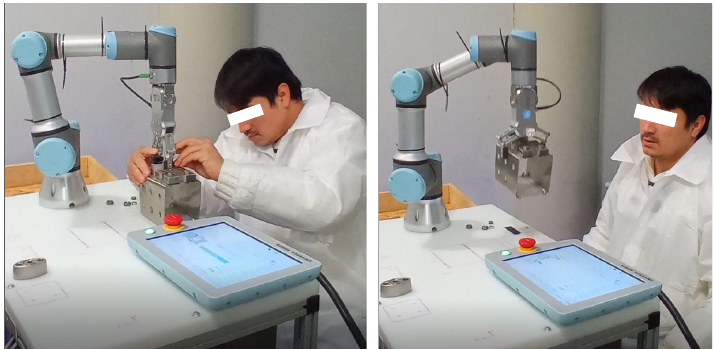
Figure 3. HRC application processes: the figure on the left demonstrates the HRC assembly pro- cess; The figure on the right demonstrates the cobot transporting assembled components to the target position.